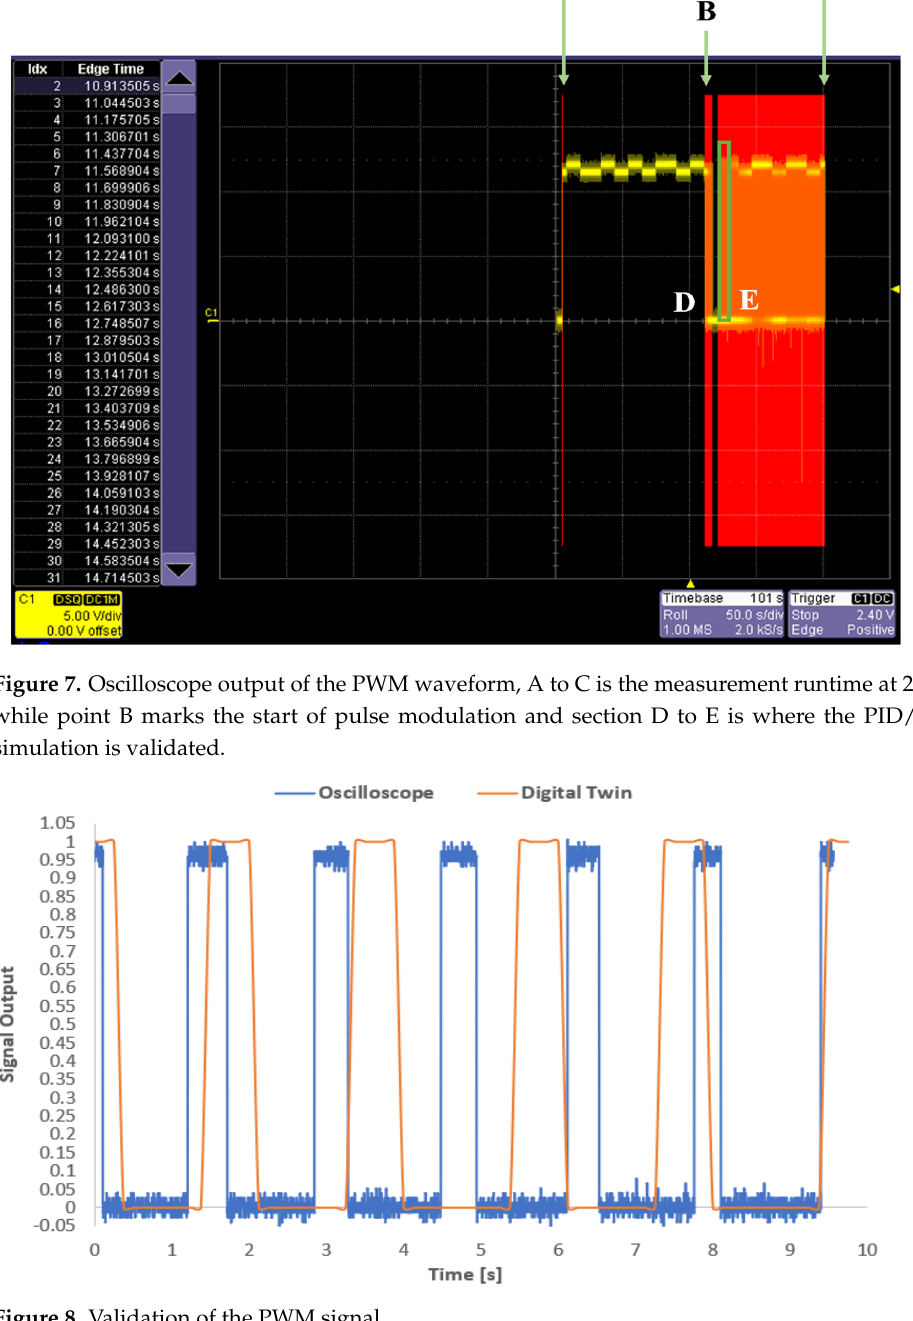
Figure 8. Validation of the PWM signal.